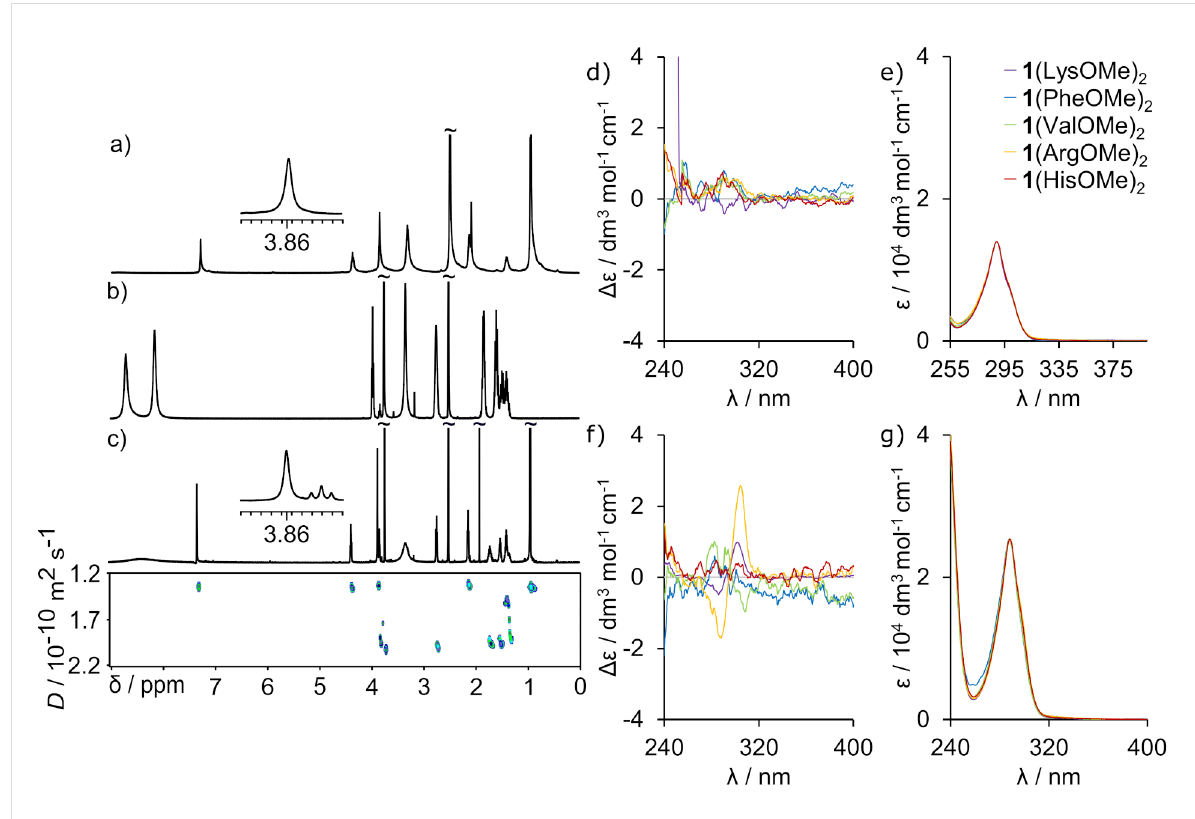
Figure 5: 1 H NMR spectra of 1 (a), LysOMe (b), 1 H NMR and DOSY spectra of [ 1 (LysOMe) 2 ] (insets show the shape of signals f, DMSO- d 6 , at 298 K, 600 MHz) (c). CD (d) and UV (e) spectra in DMSO; CD (f) and UV (g) spectra in MeOH/H 2 O (1:1) mixture. .